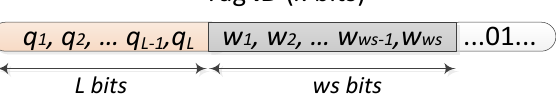
Figure 4. Structure of a tag